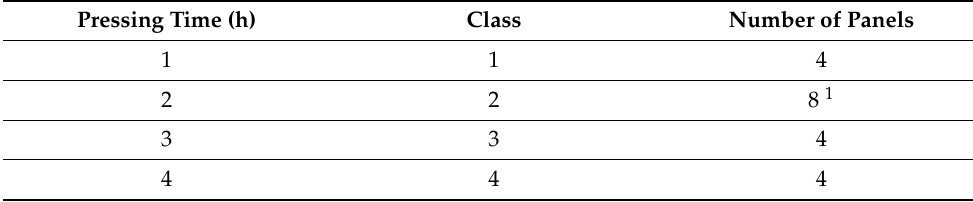
Table 2. Division of panels in classes according to their pressing